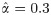
Dependence of between-group (spurious) effect size on the number of trials and between group differences in learning rates.(A) For beta values of RPE, δ, in GLM. (B) For beta value of negative value, −V, in GLM2. The fit learning rate is set to α^=0.3 for all cases. For reference, we plot horizontal dot lines indicating the effect sizes above which statistical power is higher than 50% and higher than 80% with a significance level of 0.05 and sample size of N = 20 (for each group).